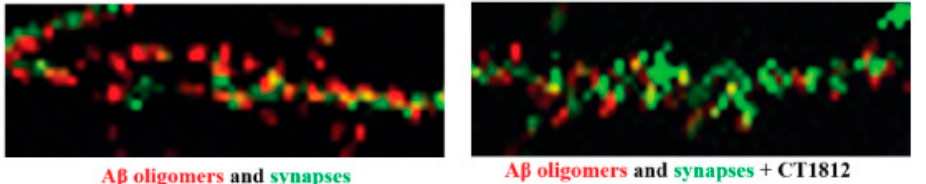
Figure 4. S2R modulator CT1812 slows the loss of synapses that is triggered by amyloid- β oligomers in vitro. High-resolution images of primary neuronal cell cultures exposed to β -amyloid oligomer are shown before the addition of CT1812 ( left ) and after the addition of CT1812 ( right ). Amyloid- β oligomers (red) bind to synaptic receptors and reduce numbers of synapses (Drebrin, green). The addition of CT1812 displaces amyloid- β oligomer binding and appears to block the effects induced by the amyloid- β oligomers, with the synapse numbers remaining at levels similar to control cultures. Reprinted with permission from Ref. [64], 2021, Izzo, et al..